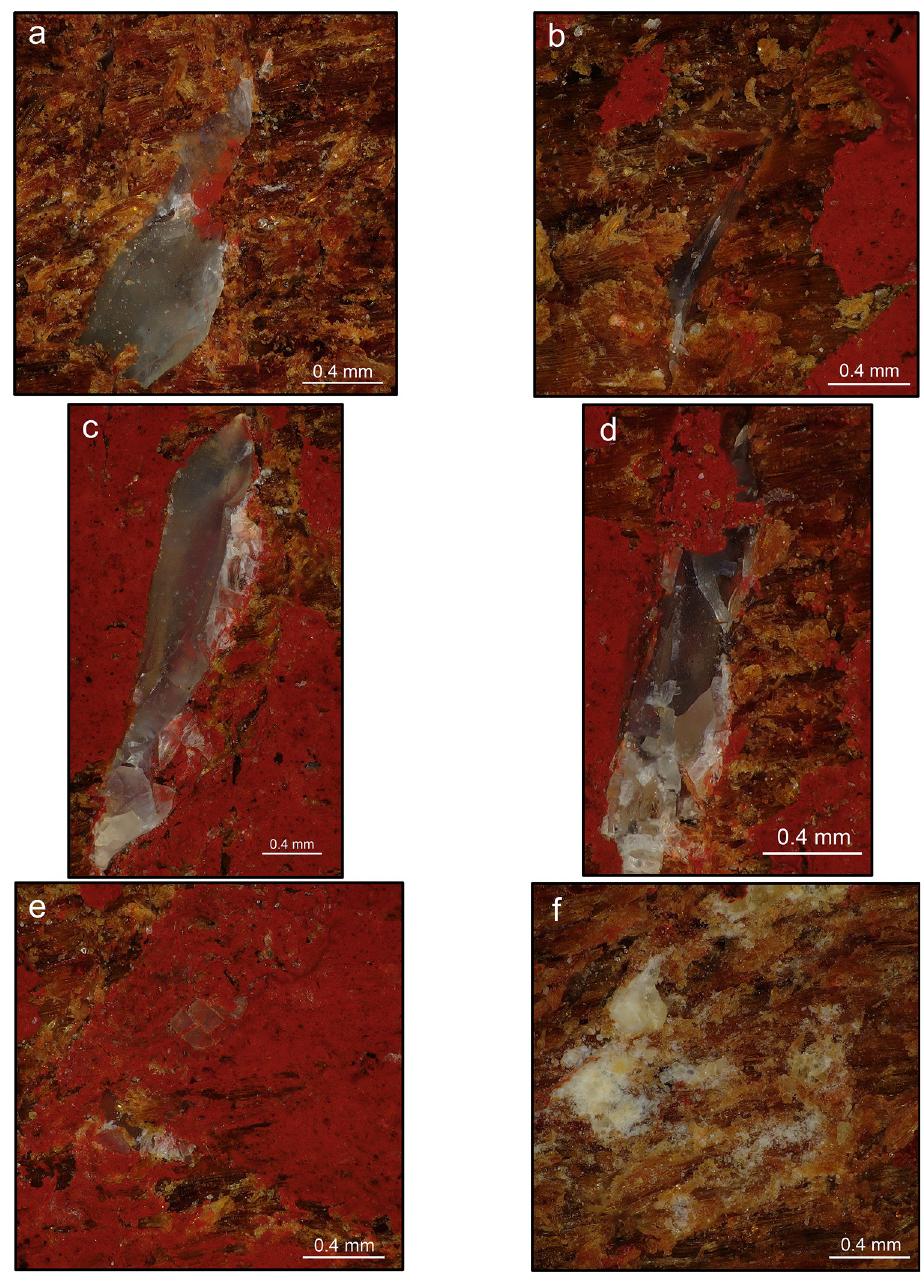
Fig 10. Flint chips embedded within the use areas on boomerangs (10x). (a) embedded flint chip mostly intact, showing paint residues owing to the use of a painted surface of the boomerang for retouching; (b) elongated flint chip creating a linear impression; (c) embedded flint chip fractured in its extremities following repeated percussion: punctiform impressions are more likely to be created as a consequence of these fractures; (d) embedded flint chip fractured in most of its surface due to repeated percussion: the micro-flakes resulting create punctiform impressions; (e) small, thin flint chip showing how each fracture of the chip itself from repeated percussion creates new impressions on the boomerang surface; (f) as a result of repeated percussion, several embedded flint chips are completely fractured leaving punctiform impressions and notches in the wooden surface.